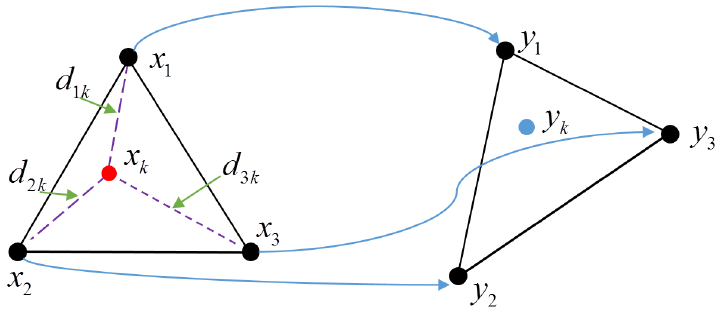
Figure 1. A simple example using three pairs of ground control points (GCPs) to compute the optimal set of transformation parameters for tie points